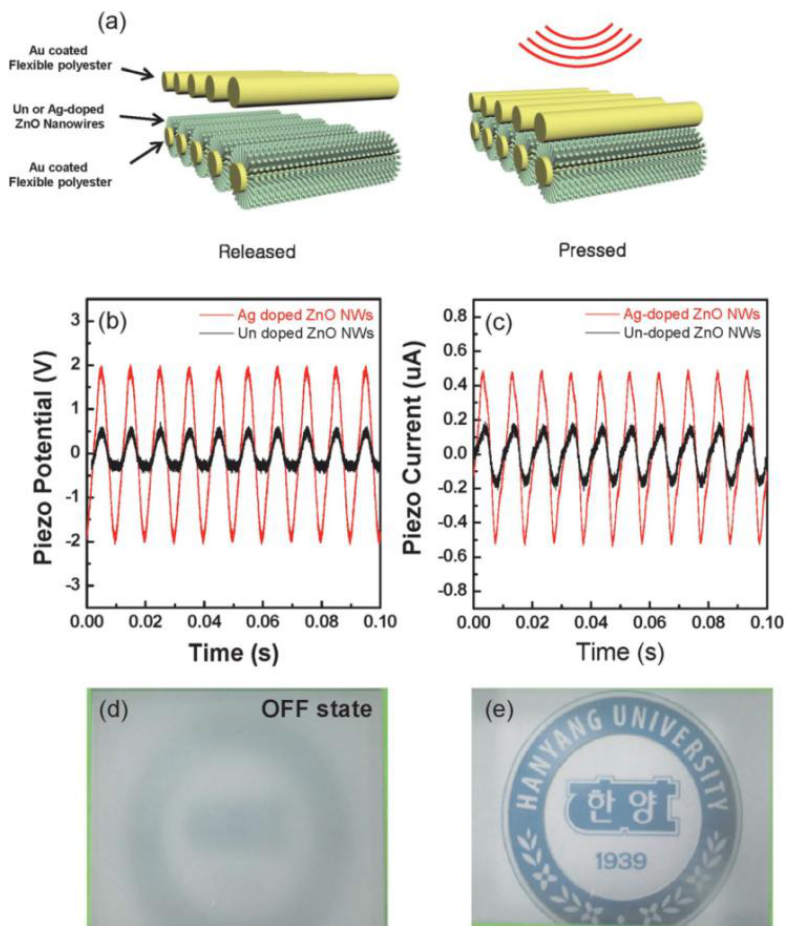
Figure 11. ( a ) Schematic diagram of device operation for the ZnO nanowire-based nanogenerator grown on the flexible polyester; ( b ) piezoelectric potential and ( c ) piezoelectric current measured from Ag-doped ZnO nanowires (red line) and un-doped ZnO nanowires, respectively, (black line) on polyester substrates using sound waves; ( d ) OFF-state of the PDLC device; ( e ) ON-state of the PDLC device after generating sound waves. Reprinted with permission from [47]. Copyright 2013 Royal Society of